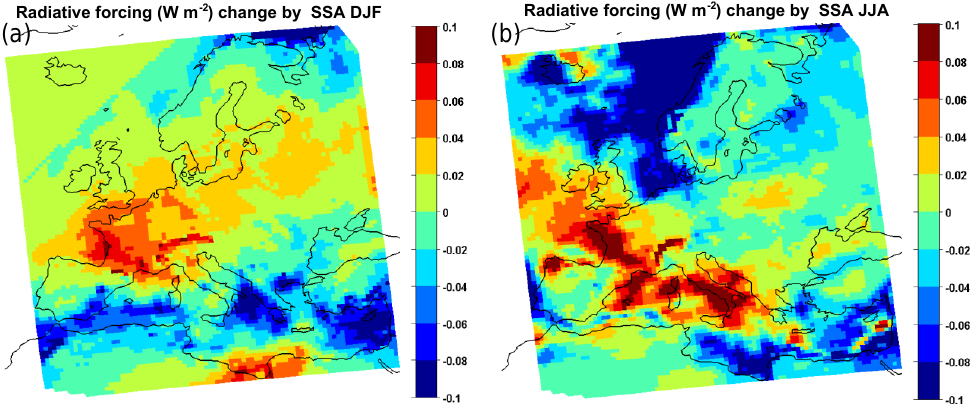
Figure 11. Radiative forcing by sea salt (Wm − 2 ): difference between future (2040–2059) and past periods. (a) Winter (December, January, and February); (b) summer (June, July, and